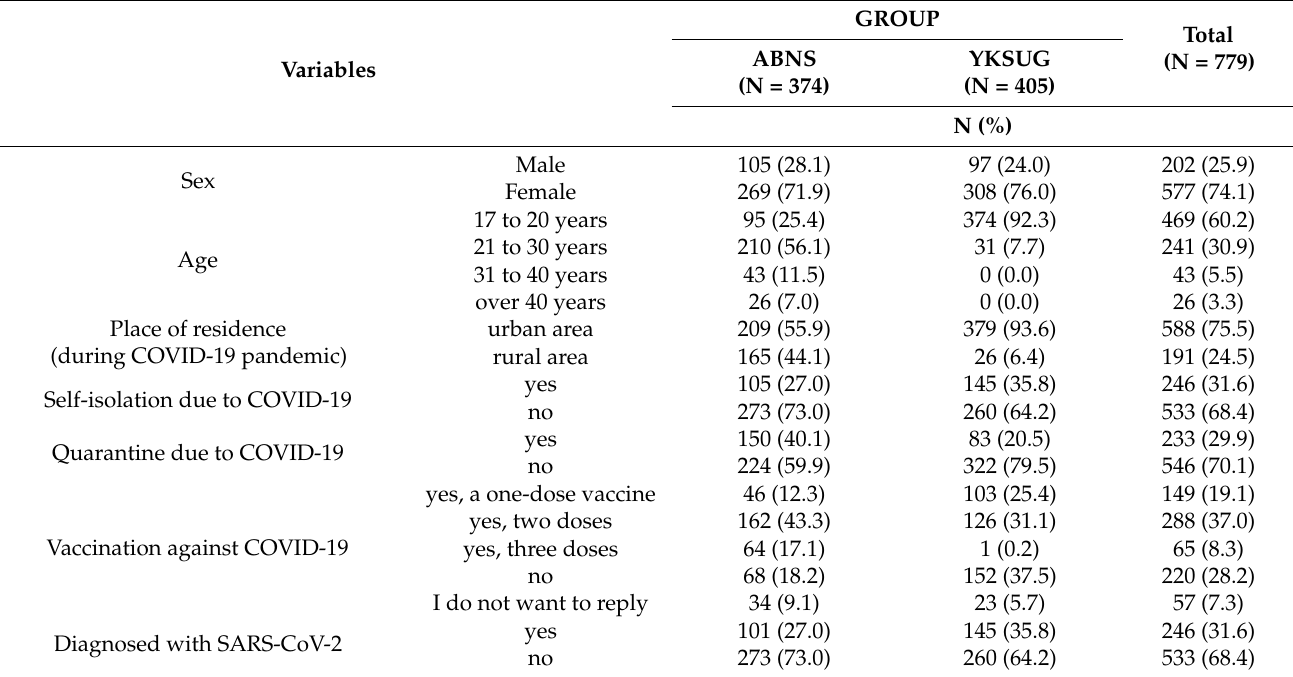
Table 1. Characteristics of the study